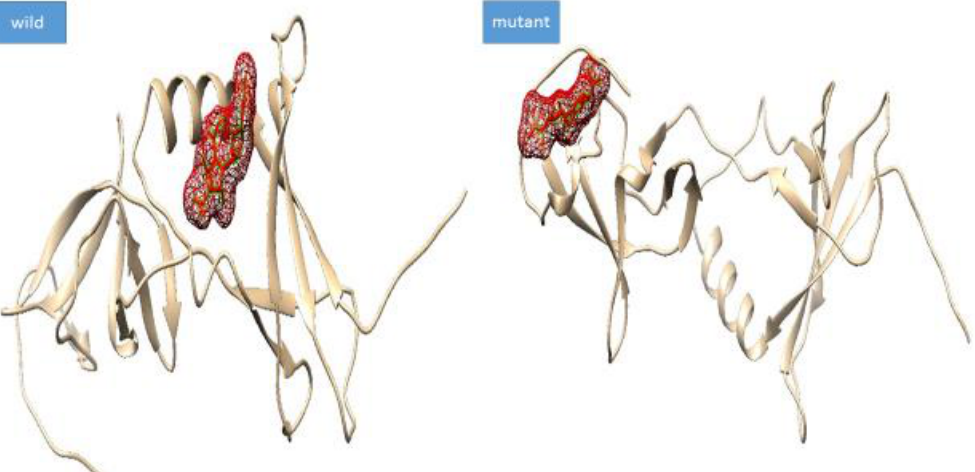
Table 13. Docking energy score in kcal/mol.